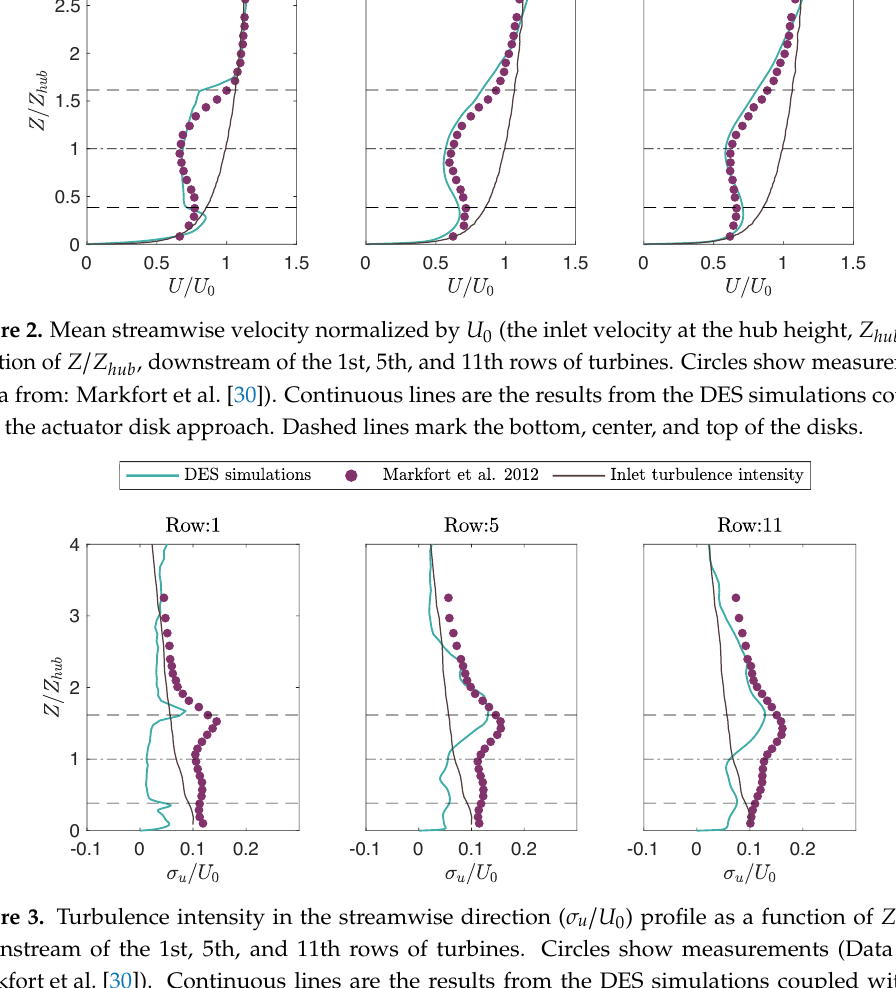
Figure 3. Turbulence intensity in the streamwise direction ( σ u / U 0 ) profile as a function of Z / Z hub , downstream of the 1st, 5th, and 11th rows of turbines. Circles show measurements (Data from: Markfort et al. [30]). Continuous lines are the results from the DES simulations coupled with the actuator disk approach. Dashed lines mark the bottom, center, and top of the